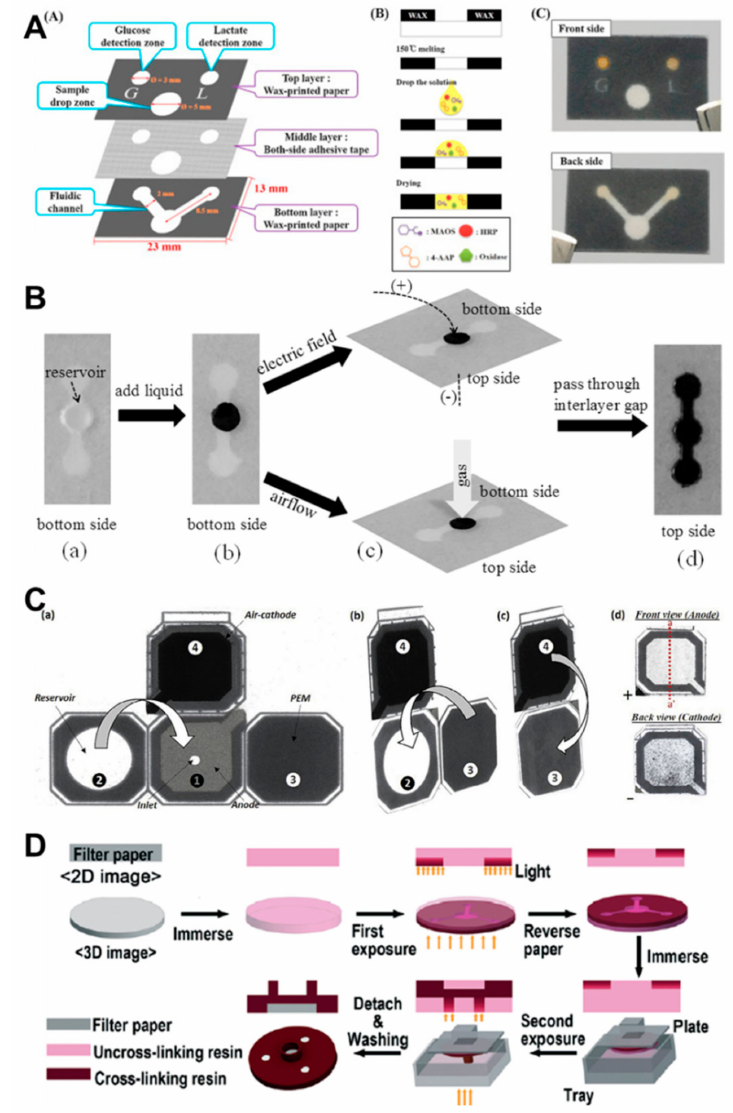
Figure 3. Three-dimensional paper-based microfluidic devices. ( A ) Stacking method using both-side adhesive tape (reprinted from ref [82] with permission from Elsevier, Copyright 2016), ( B ) 3D printer (reprinted from ref [88] with permission from Elsevier, Copyright 2019), ( C ) Origami method using wax-printed 2D paper sheets (reprinted from ref [95] with permission from Elsevier, Copyright 2017), ( D ) Double-sided 3D printing method using digital light processing printer (reproduced from ref [100] with permission from the Royal Society of Chemistry.